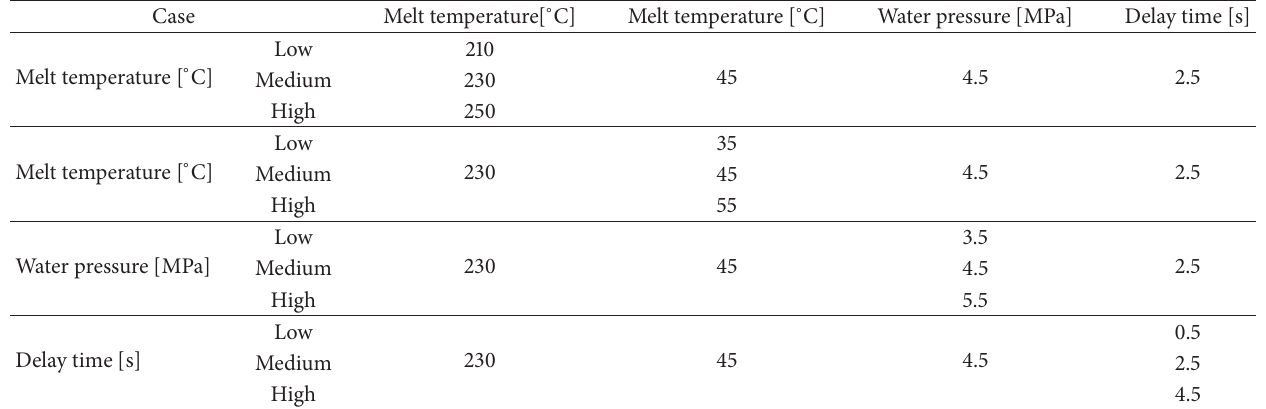
Figure 9: Definition of parameters for (a) the evaluation of residual wall thickness and (b) the calculation of average residual wall thickness using the elliptic equation. Table 3: Experiment design for